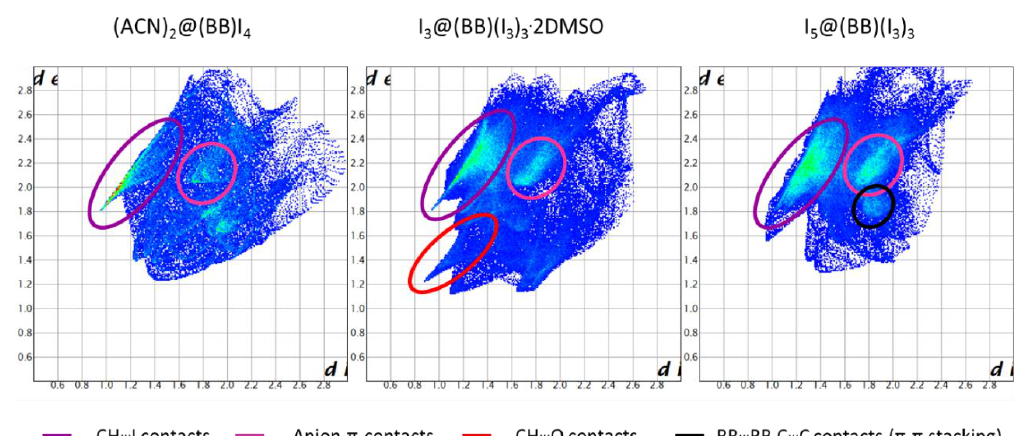
Figure 8. Overview of BB fingerprint plots for all discussed crystal structures. A breakdown of assignment of recognizable features is presented in Figure S1. Partly adapted from [27] with permission from John Wiley and Sons.